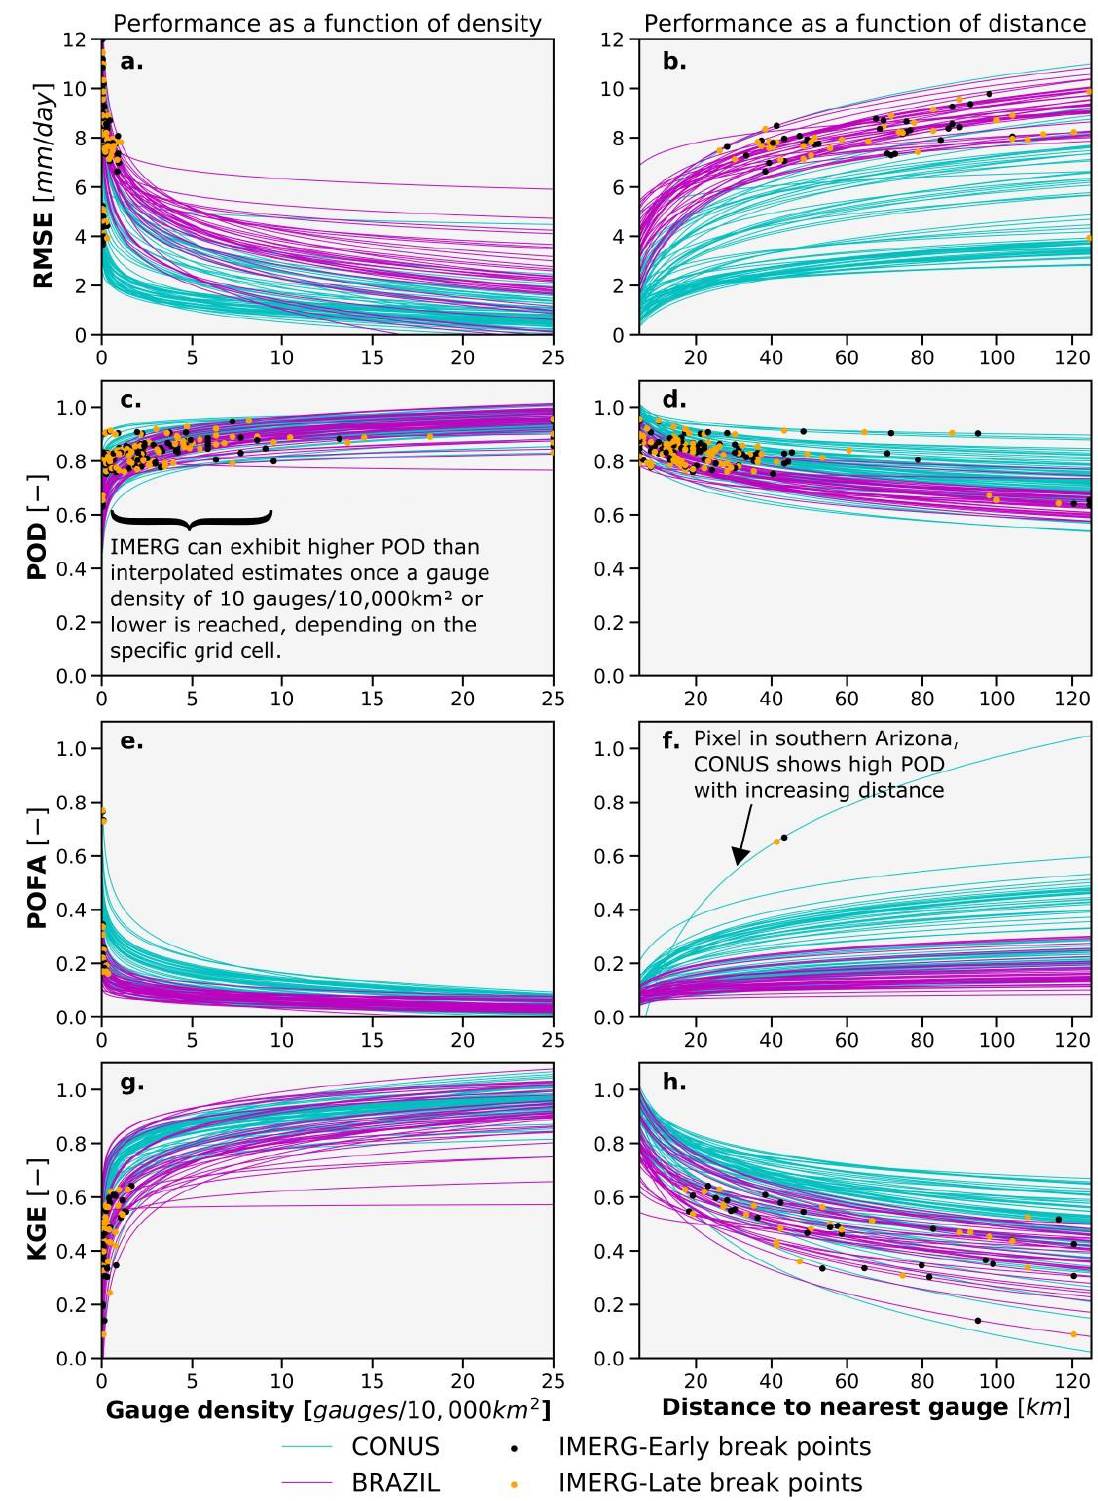
Figure 3. Logistic regression results fit to the performance metrics (RMSE, POD, POFA, and KGE) of data-limited gauge interpolations for pixels in CONUS (blue) and Brazil (pink) as a function of ( a , c , e , g ) simulated gauge density and ( b , d , f , h ) simulated distance to nearest gauge. The “break-even” gauge densities for each pixel are plotted for IMERG-Early (black) and IMERG-Late (orange). Logistic regressions with r2 < 0.5 are excluded from this plot.